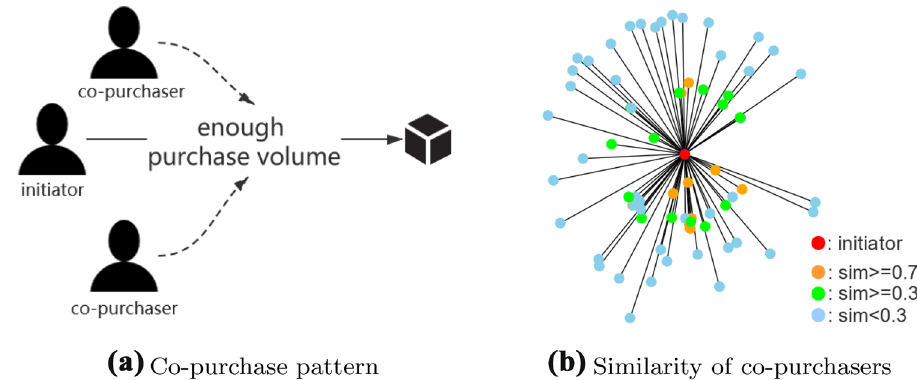
Table 1 Difference between co-purchaser recommendation and other